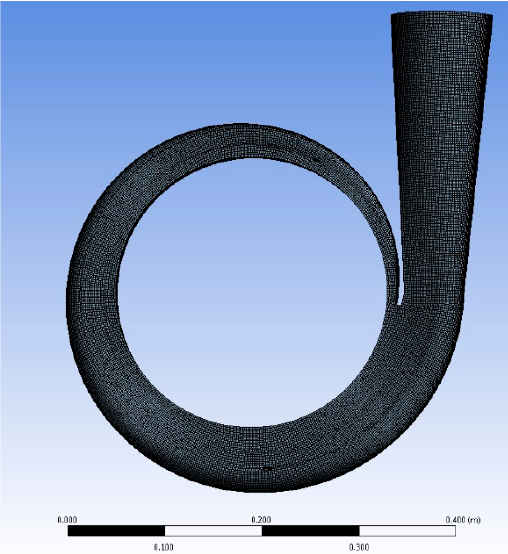
Figure 5. The unstructured meshes of the volute casing.